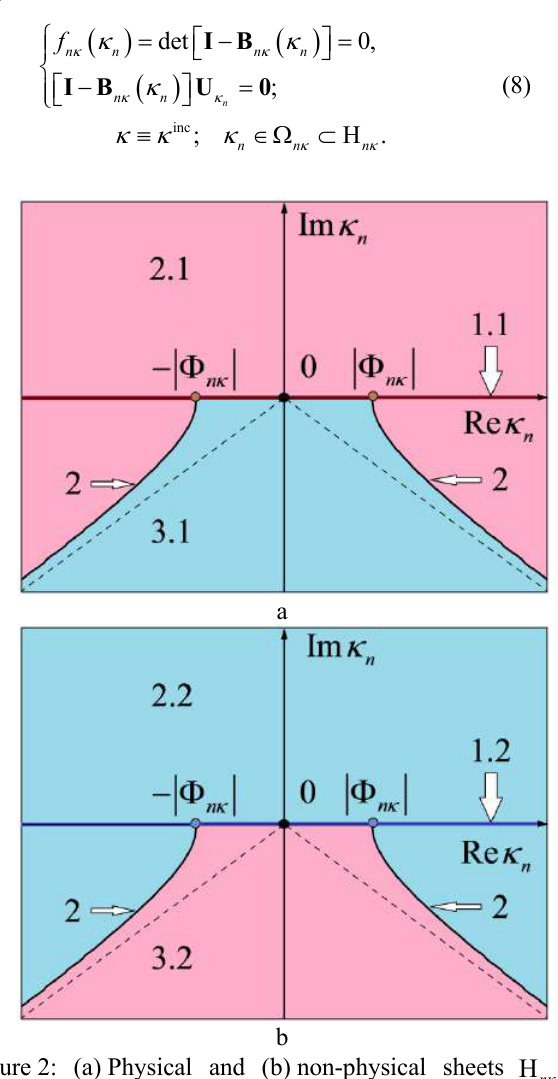
Figure 2: (а) Physical and (b) non-physical sheets Branch points